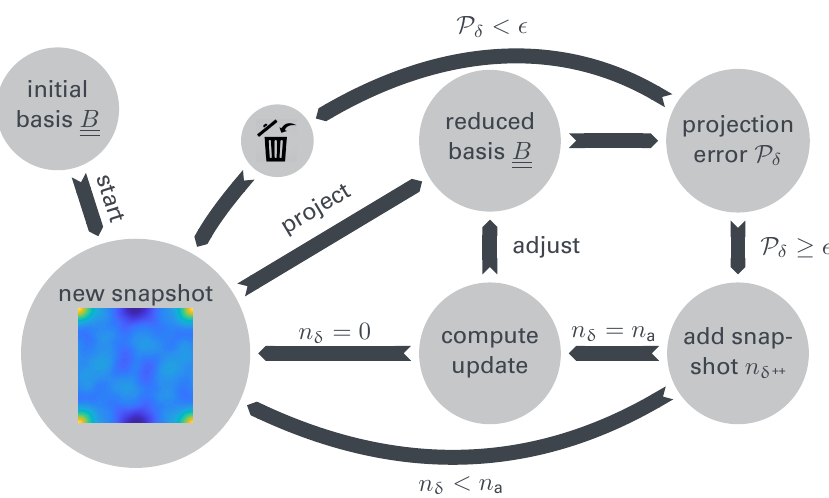
Figure 2. Graphical overview of the incremental update of the reduced